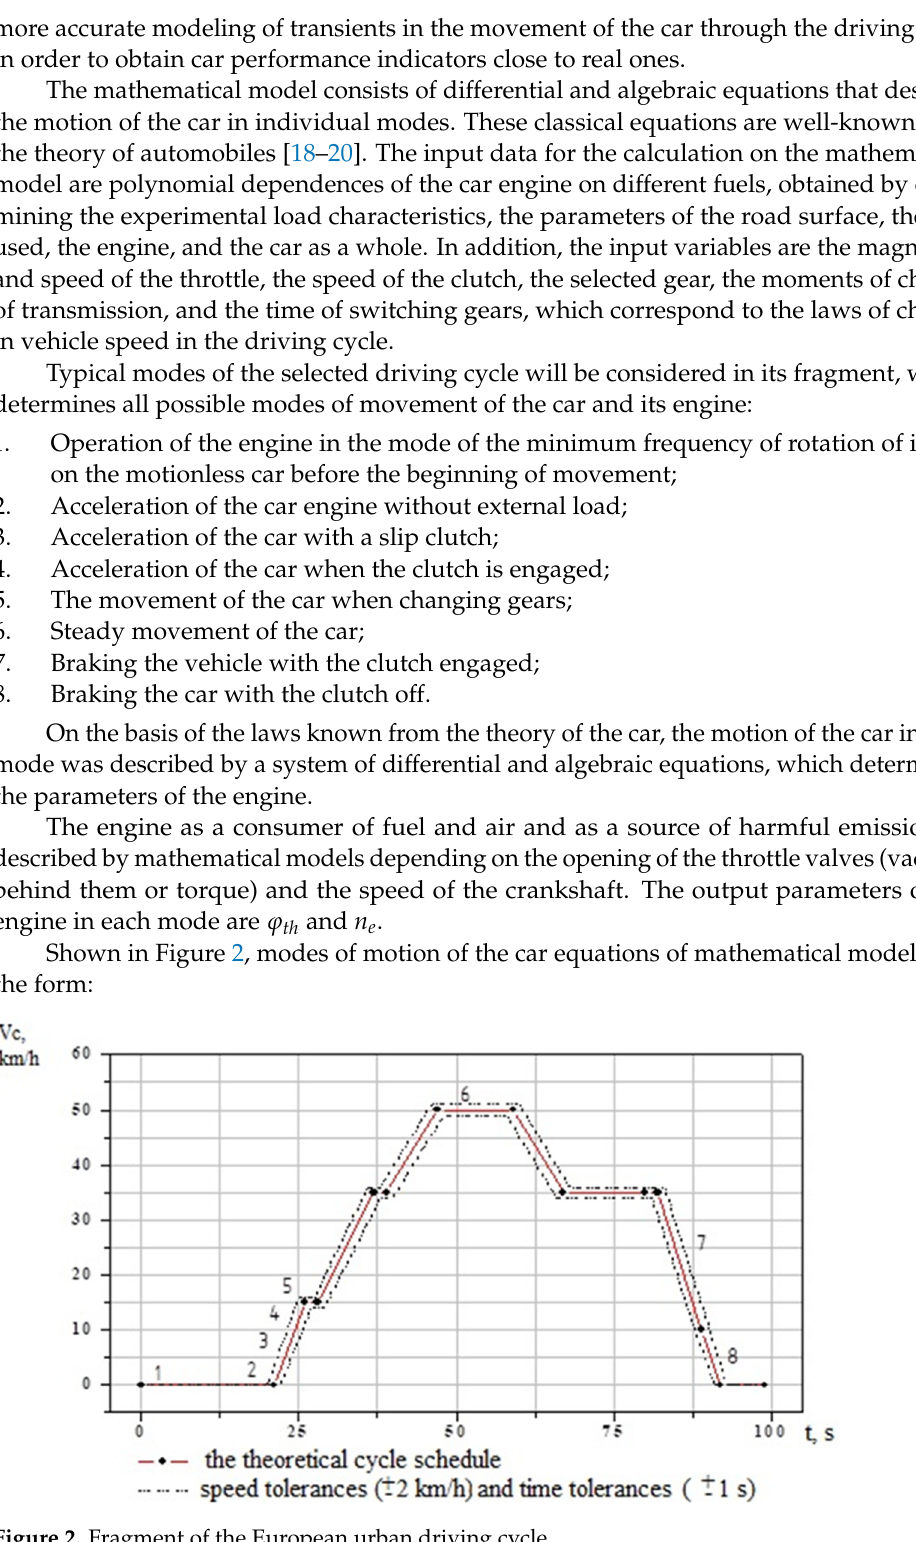
Figure 2. Fragment of the European urban driving cycle.